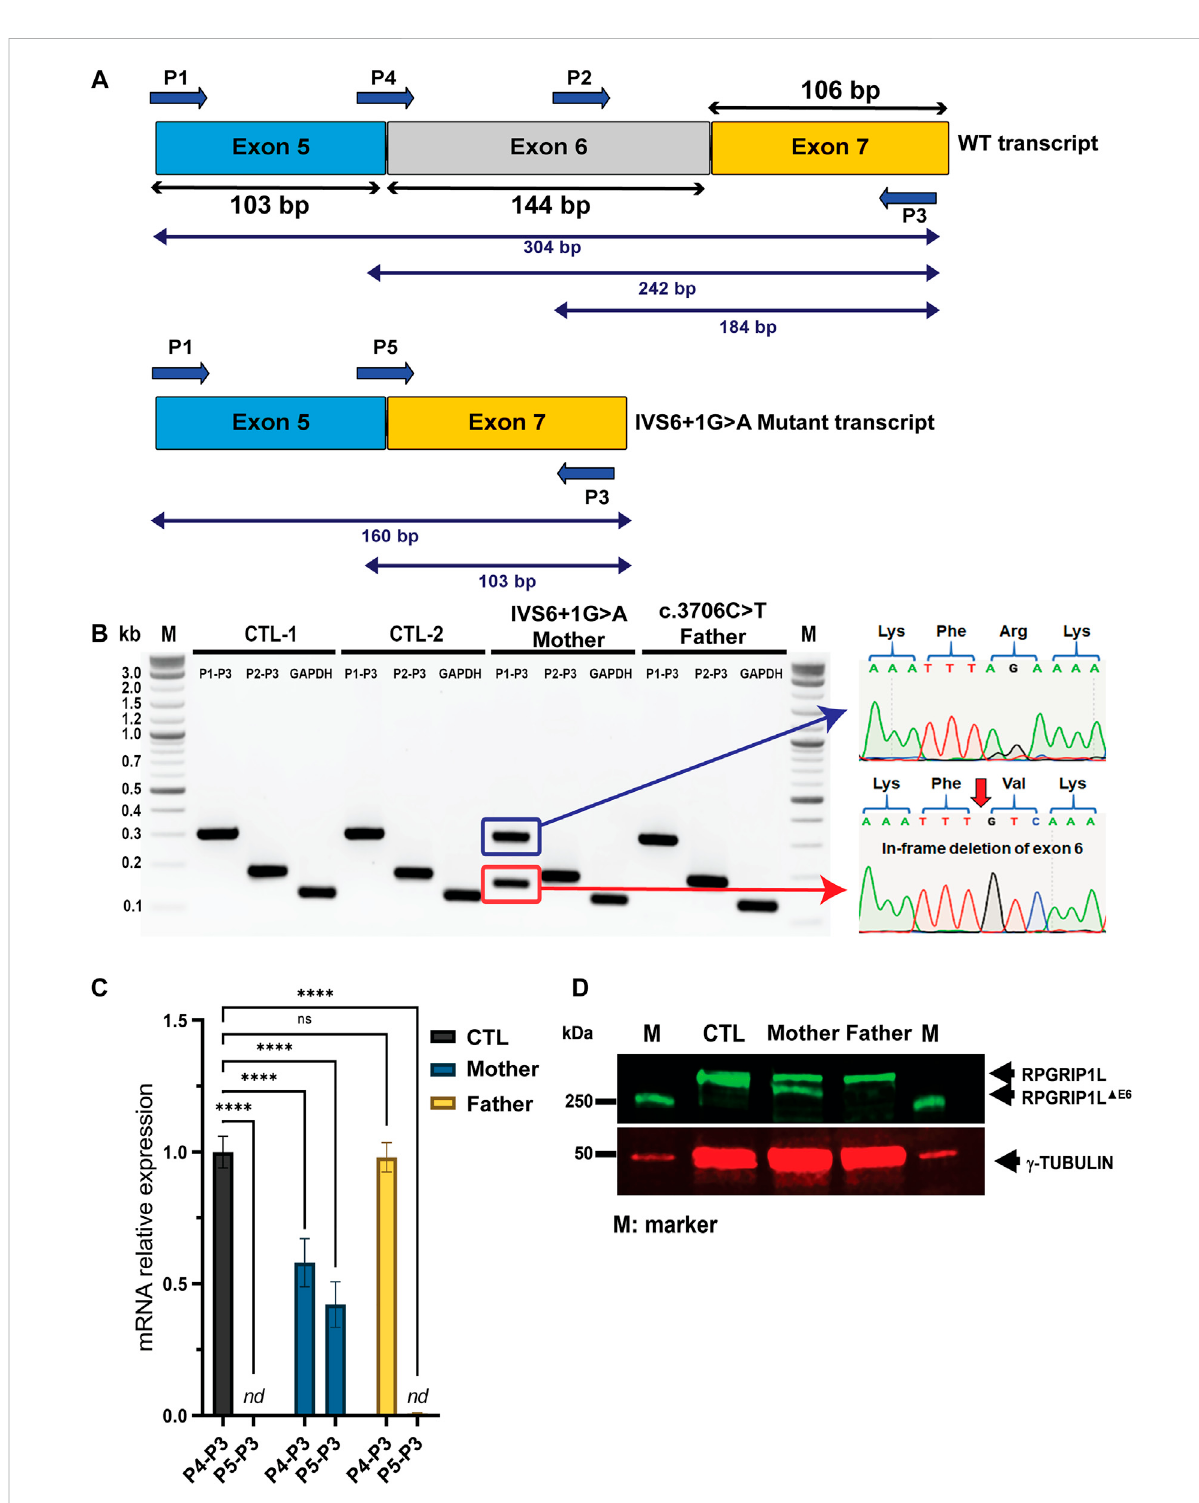
FIGURE 2 Molecularcharacterizationofthenovel RPGRIP1L IVG6+1G > AmutationinaCanadianfamilywithfrequentbirthmiscarriage. (A) Structureofthe